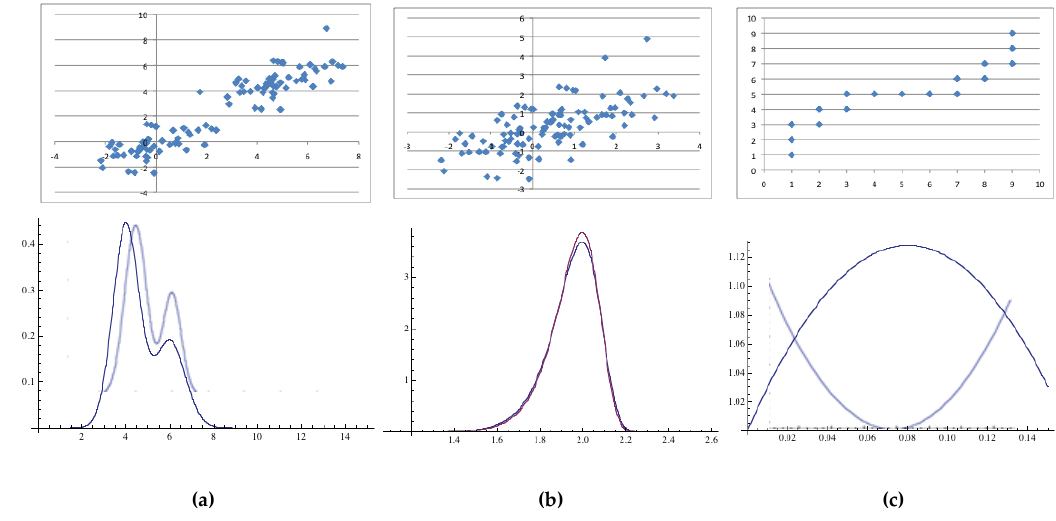
Figure 2. Various types of co-kurtosis: ( a ) positive lepto co-kurtosis; ( b ) positive plati co-kurtosis; ( c ) negative co-kurtosis. Scatter diagrams (upper panel); probability density functions (lower panel).